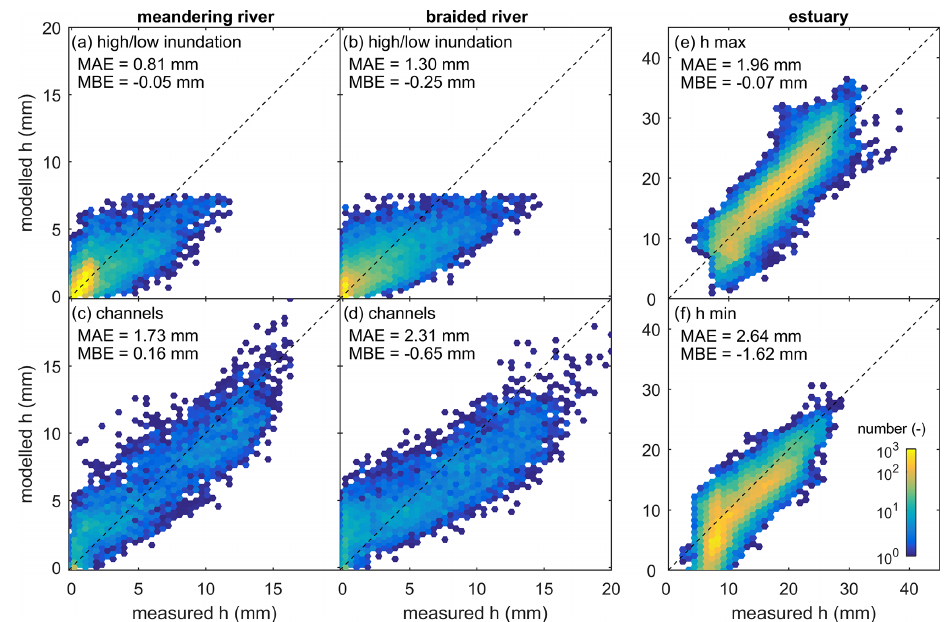
Figure 5. Comparison between measured and modelled water depths for different classes for the (a, c) meandering and (b, d) braided rivers, as well as for the (e) maximum and (f) minimum water depths in the estuary. The scatter density plots exclude floodplain and erroneous measured data (e.g. due to white silica flour), which are included in Figs. S2 (rivers) and S3 (estuary). Colours indicate the occurrence